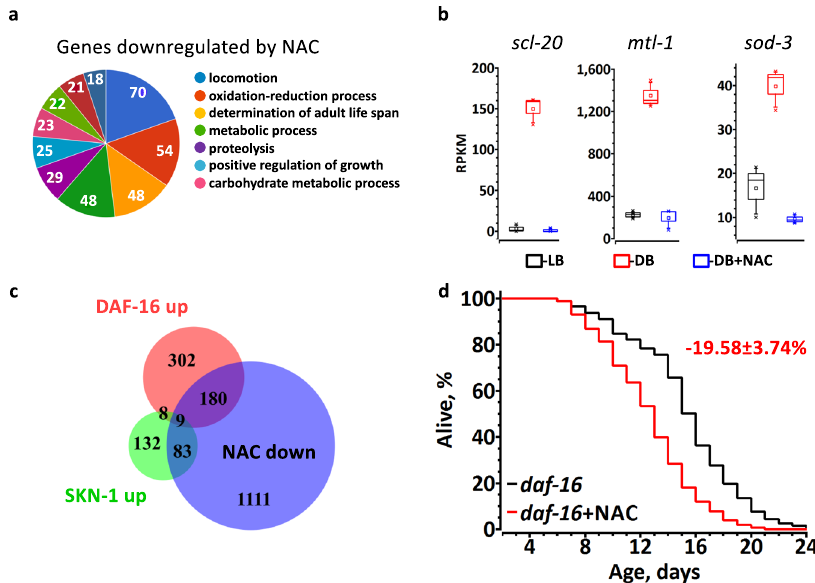
Fig. 3 NAC downregulates DAF-16 and SKN-1-dependent transcription. a The most enriched categories (gene ontology) among genes downregulated by NAC. Numbers indicate the number of genes per a category; see Supplementary Data 1 for the full list of differentially regulated genes, and Supplementary Fig. 3 for statistics. b Regulation of representative DAF-16 dependent genes by LB, DB or DB + NAC. Graphs show RPKM of three independent experiments from RNA-seq. Box plots indicate median (middle line), 25th, 75th percentile (box) and 5th and 95th percentile (whiskers) as well as maximum, minimum and mean (single points).See Supplementary Data 1 for statistics. c Statistically signi fi cant overlap between the sets of genes downregulated by NAC and 500 top-ranked DAF-16- (189 genes, RF = 5.6, p value = 4.28e − 93) and SKN-1- (92 genes, RF = 5.9, p value = 3.01e − 47) dependent genes under normal growth conditions. RF – representation factor is the number of overlapping genes divided by the expected number of overlapping genes drawn from two independent groups and p is normal approximation of hypergeometric probability. d NAC (5 mM) shortens the lifespan of daf-16 worms. Average percentage change ±SD of the lifespan relative to untreated control is indicated in red ( n = 304(untreated), 305(5 mM